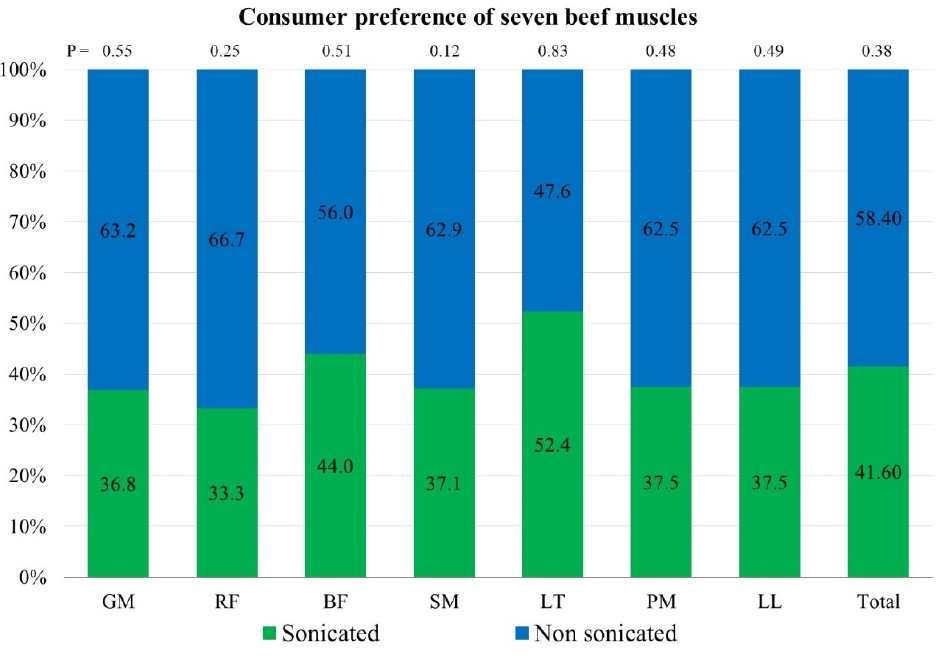
Figure 3. Percentage of consumer preference by tenderness of seven 23-day-aged beef muscles in simulated retail display (75% O 2 : 25% CO 2 , 3 °C) for 5 d. BF = Biceps femoris . GM = Gluteus medius . LL = Longissimus lumborum . LT = Longissimus thoracis . PM = Psoas major . RF = Rectus femoris . SM = Semitendinosus .